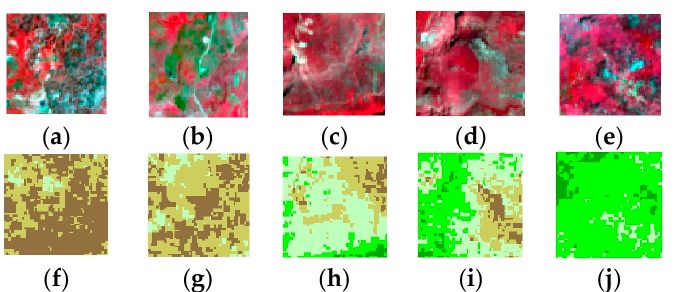
Figure 11. Sentinel-2 sub-images (64 × 64): ( a – e ) original and ( f – j ) canopy density (very low (dark brown) to very high (dark green)).